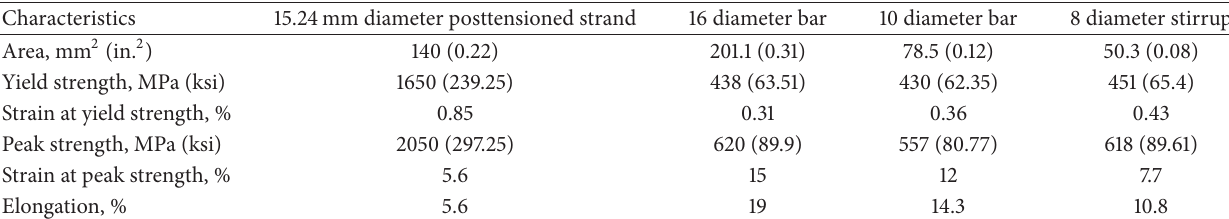
Table 1: Tensile properties of steel